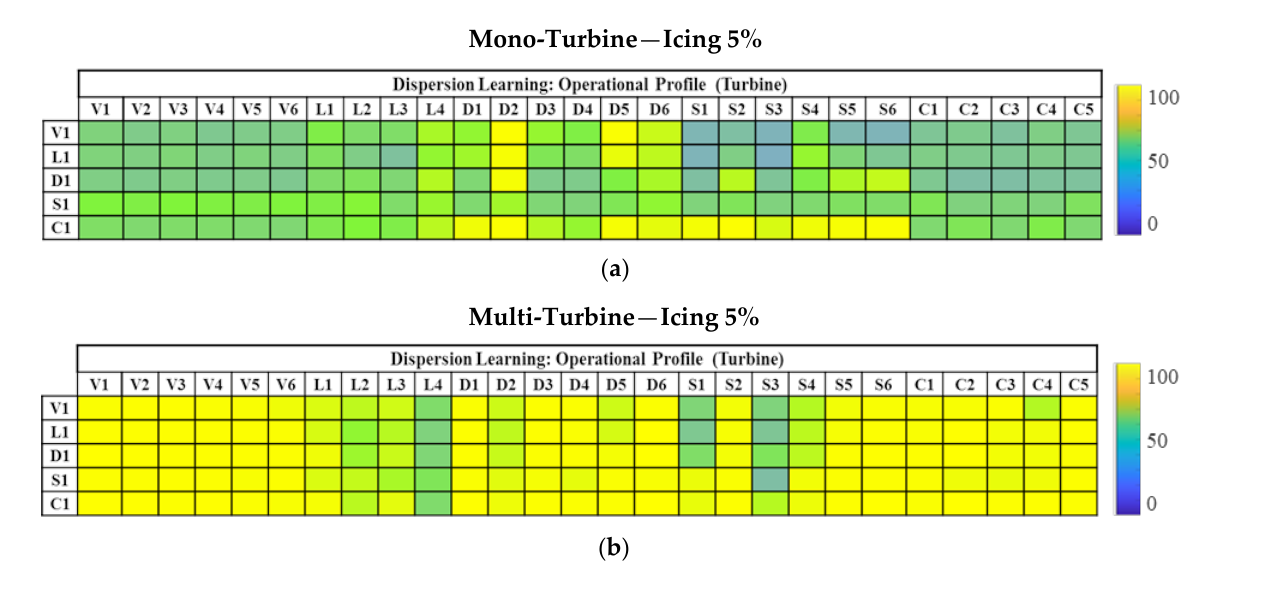
Table 2. ( a ). Performance comparison of Method 1 vs Method 2 — Mono-Turbine config. ( b ). Per- formance comparison of Method 1 vs Method 2 — Multi-Turbine config. ( c ). Performance gain of Multi-Turbine over Mono-Turbine.